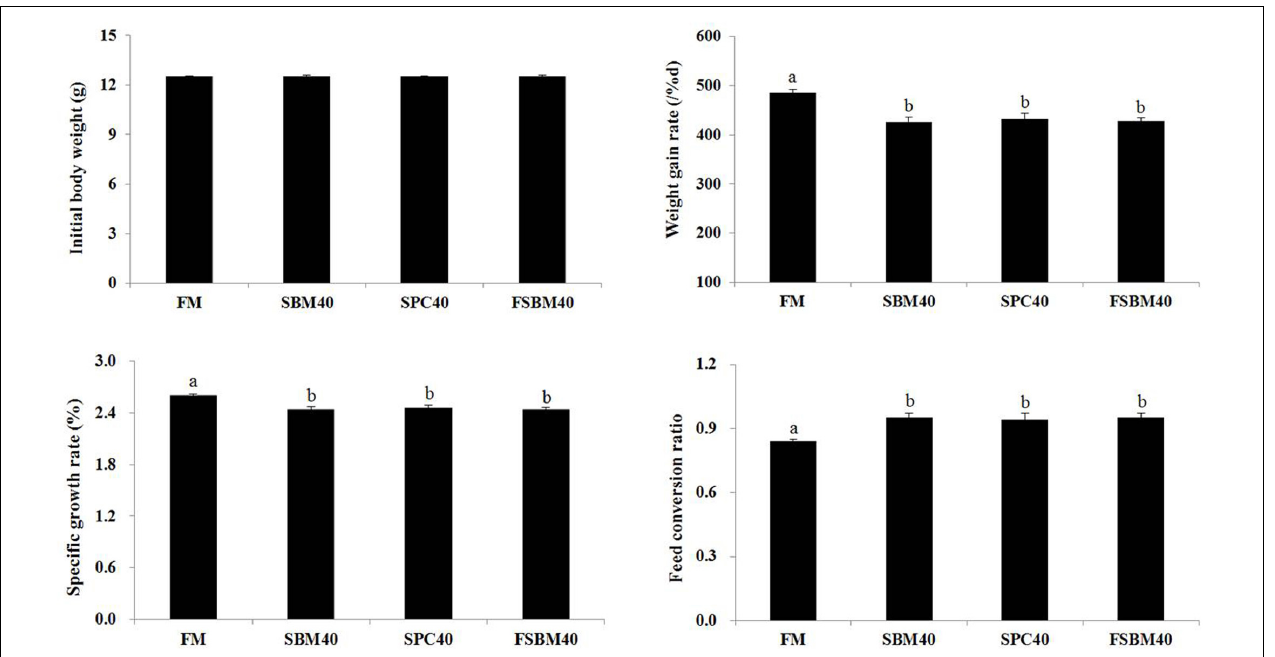
FIGURE 1 | Effect of the different soy proteins at 40% substitution levels for fish meal on the growth of the pearl gentian grouper ( n = 3). TABLE 1 | Effect of different soy protein substitutions for fish meal protein on the distal intestine morphology of the pearl gentian grouper ( n = 10). Parameters